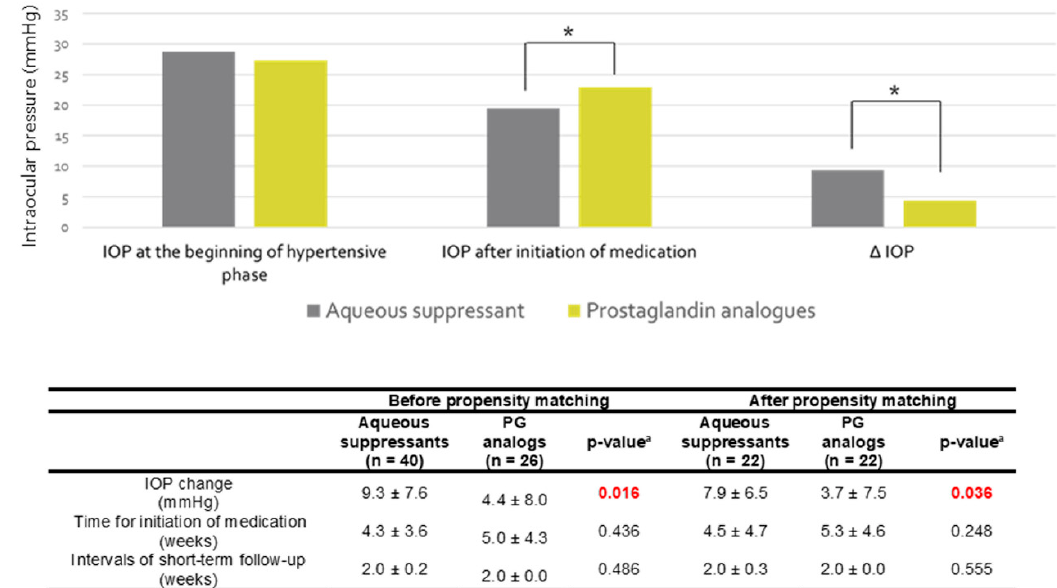
Figure 2. Short-term intraocular pressures (IOP) changes after the initiation of the glaucoma medications. a Student’s t -test Red font indicates significant p values ( p < 0.05), * p < 0.05.